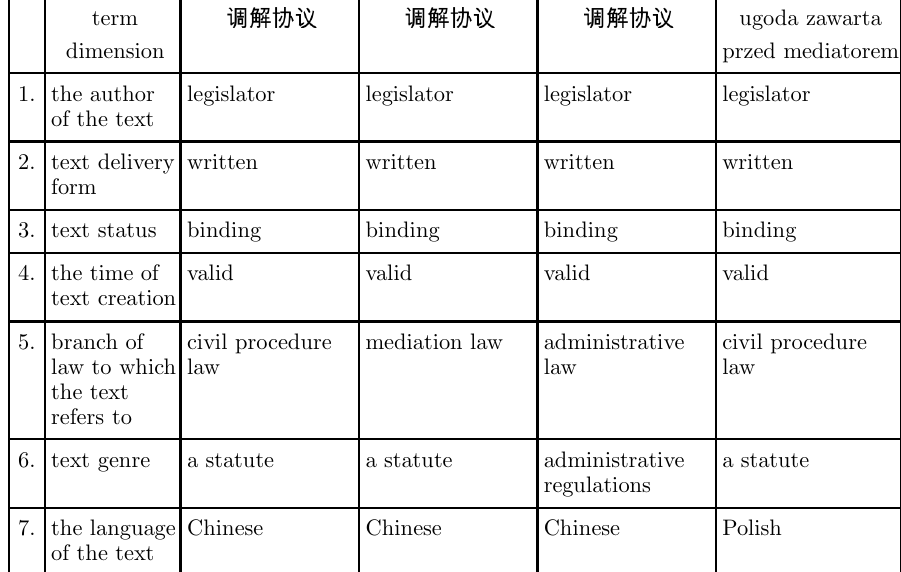
Parameterisation of the term